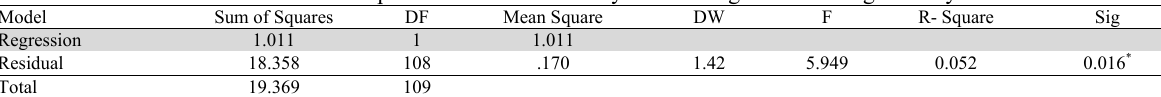
The result for ANOVA for the relationship between Information System Strategies and strategic HR systems